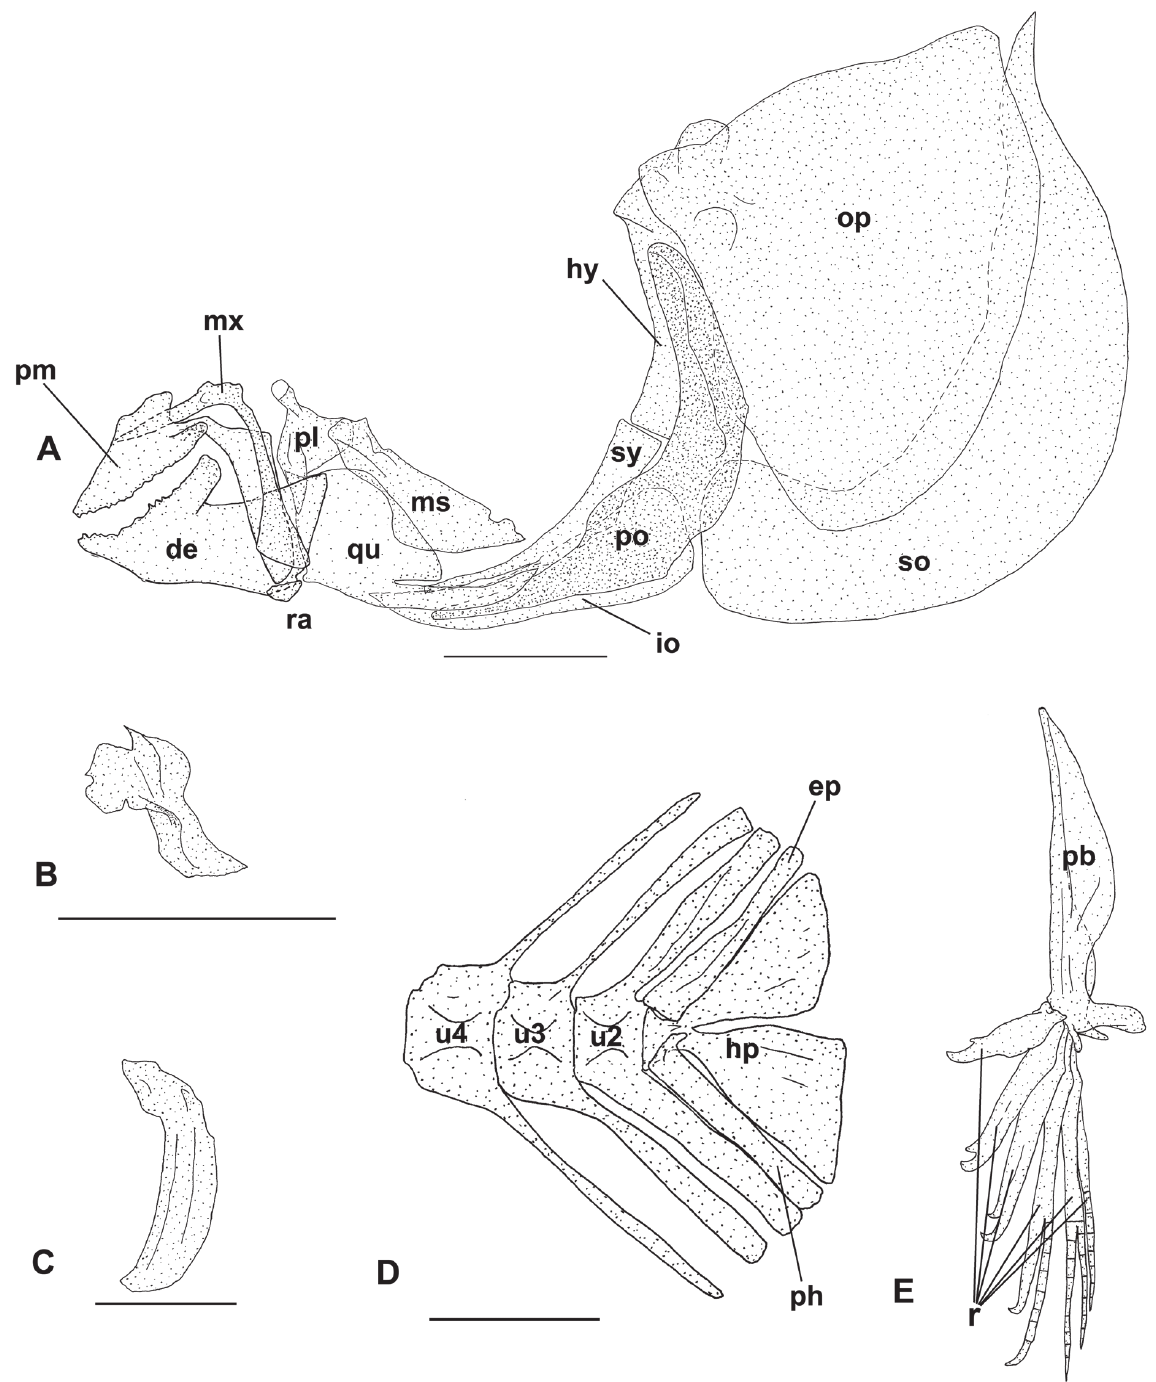
Figure 2. Jaws, jaw suspensorium, opercular apparatus, superficial dermal bones and caudal fin skeleton of Pantanodon stuhlmanni and pelvic fin of P. madagascariensis : A : left jaws, jaw suspensorium and opercular apparatus, lateral view; B , left nasal, dorsal view; C , left lachrymal, lateral view; D , caudal fin skeleton, left lateral view; E : pelvic fin bone and rays. Abbreviations: de, dentary; ep, epural; hp, hypural plate; hy, hyomandibula; io, interopercle; ms, mesopterygoid; pb, pelvic bone; ph, parahypural; pl, palatine; pm, premaxila; po, preopercle; qu, quadrate; r, rays; ra, retroarticular; so, subopercle; sy, sympletic; u2–u4, preural centra 2–4. Scale bar = 1mm. Figure 2E was based on illustration present in Rosen (1965), that originally do not have scale